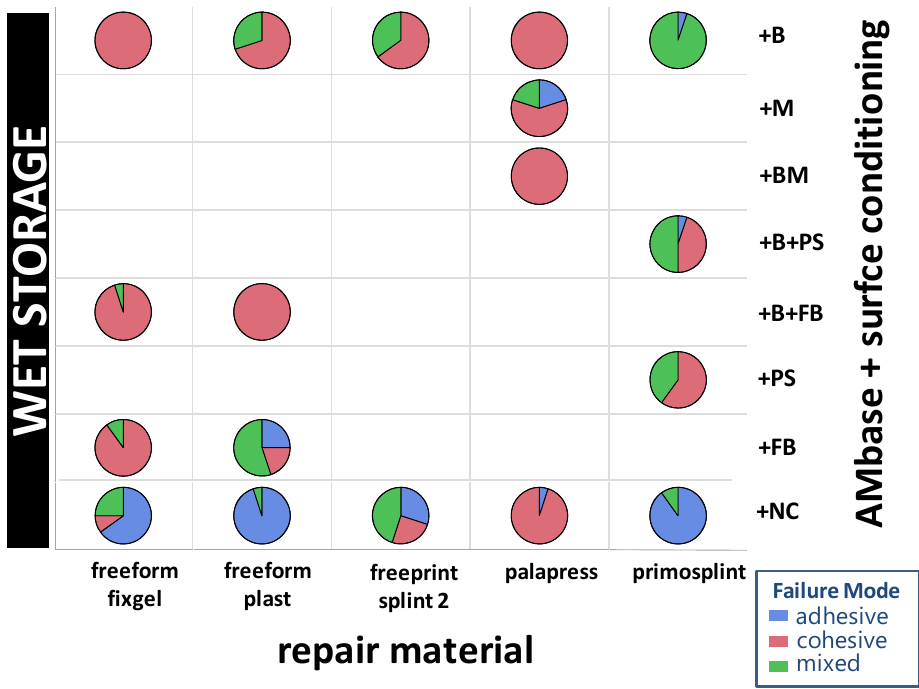
Figure 10. Distribution of failure modes of the repair materials ( x -axis) against AM base splint material depending on the conditioning (right y -axis) after wet storage. Rectangles without pie charts were not performed in wet storage condition due to protocol.